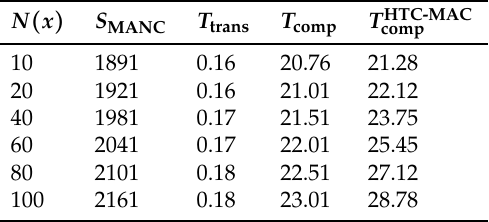
Table 4. Manc packet delay in Emmac protocol.